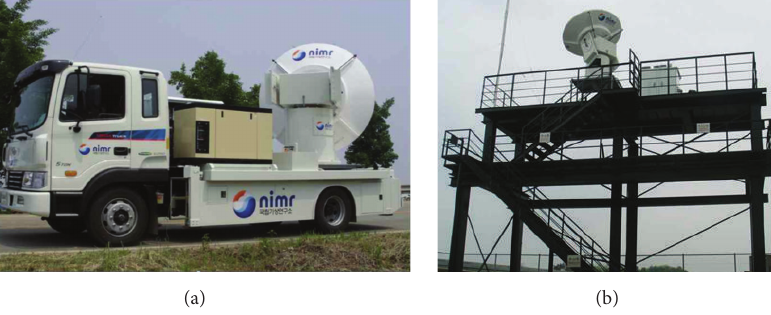
Figure 1: Photographs of the NIMS-XPOL radar installed onto (a) a truck bed and (b) a steel tower bed (courtesy of